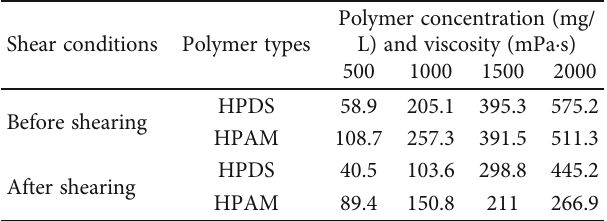
Figure 8: Relationship between apparent viscosity and temperature. Table 1: Data of HPDS and HPAM shear resistance